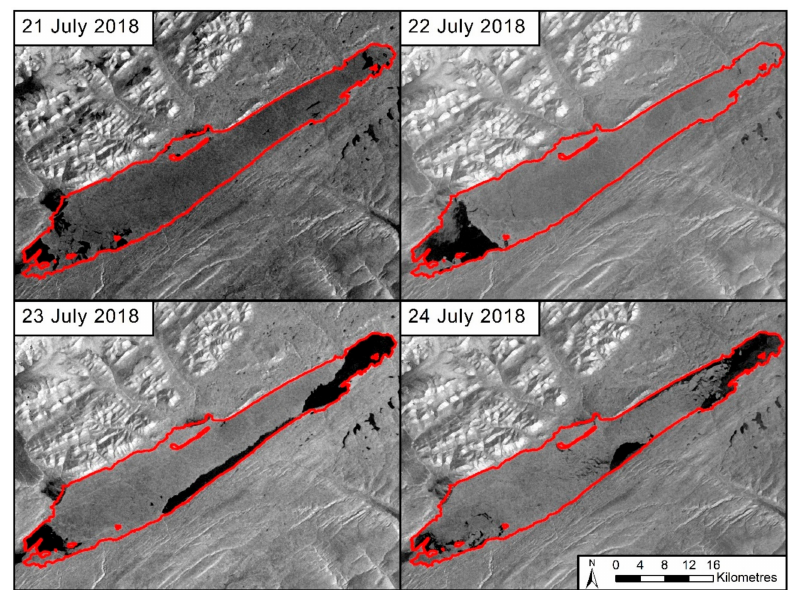
Figure 13. Shifting ice cover between 21 July and 24 July, showing the appearance of a large open water section on 22 July, which is covered the following day on 23 July. All images were acquired between 12:31:48 UTC and 13:29:01 UTC on their respective days. This figure contains Copernicus Sentinel-1 data (2018), processed by